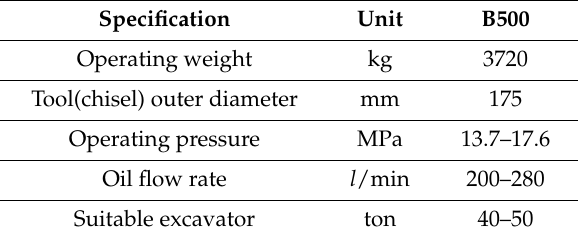
Table 3. Specifications of products used in the experiment.